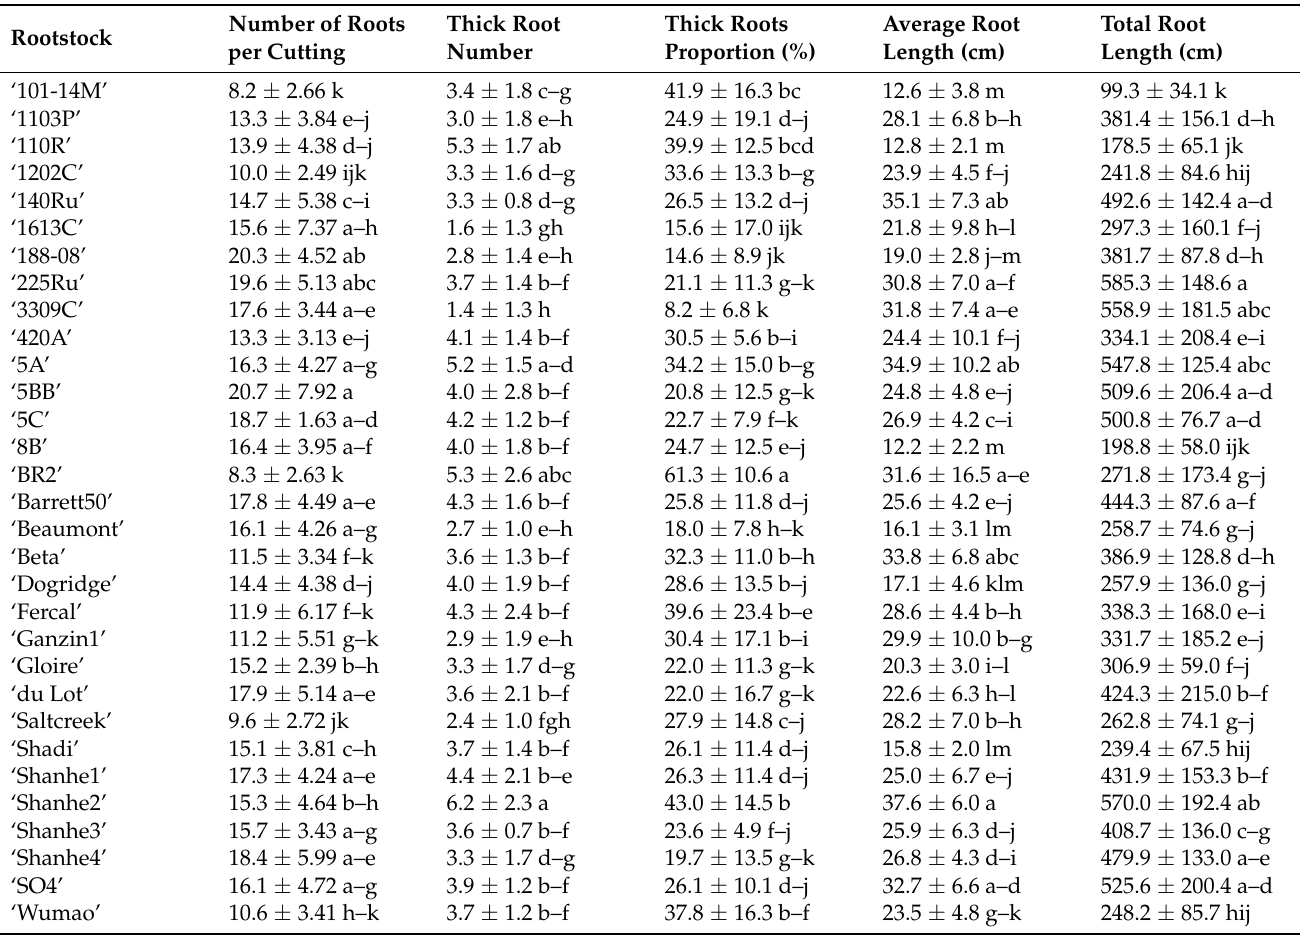
Table 4. Growth indicators of the roots 90 days after planting the grapevine rootstock cuttings in the field (the young